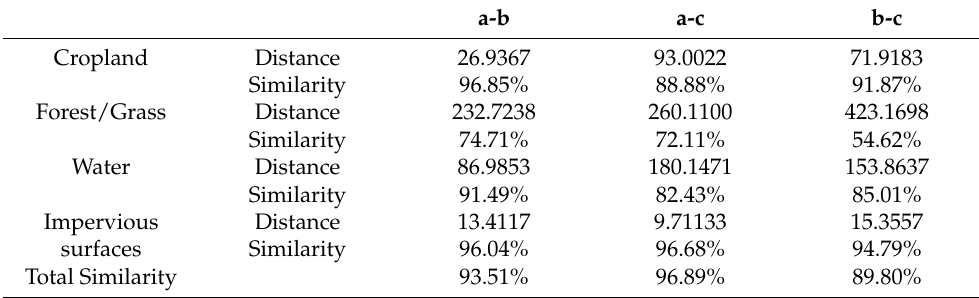
Table 7. Results of three datasets.